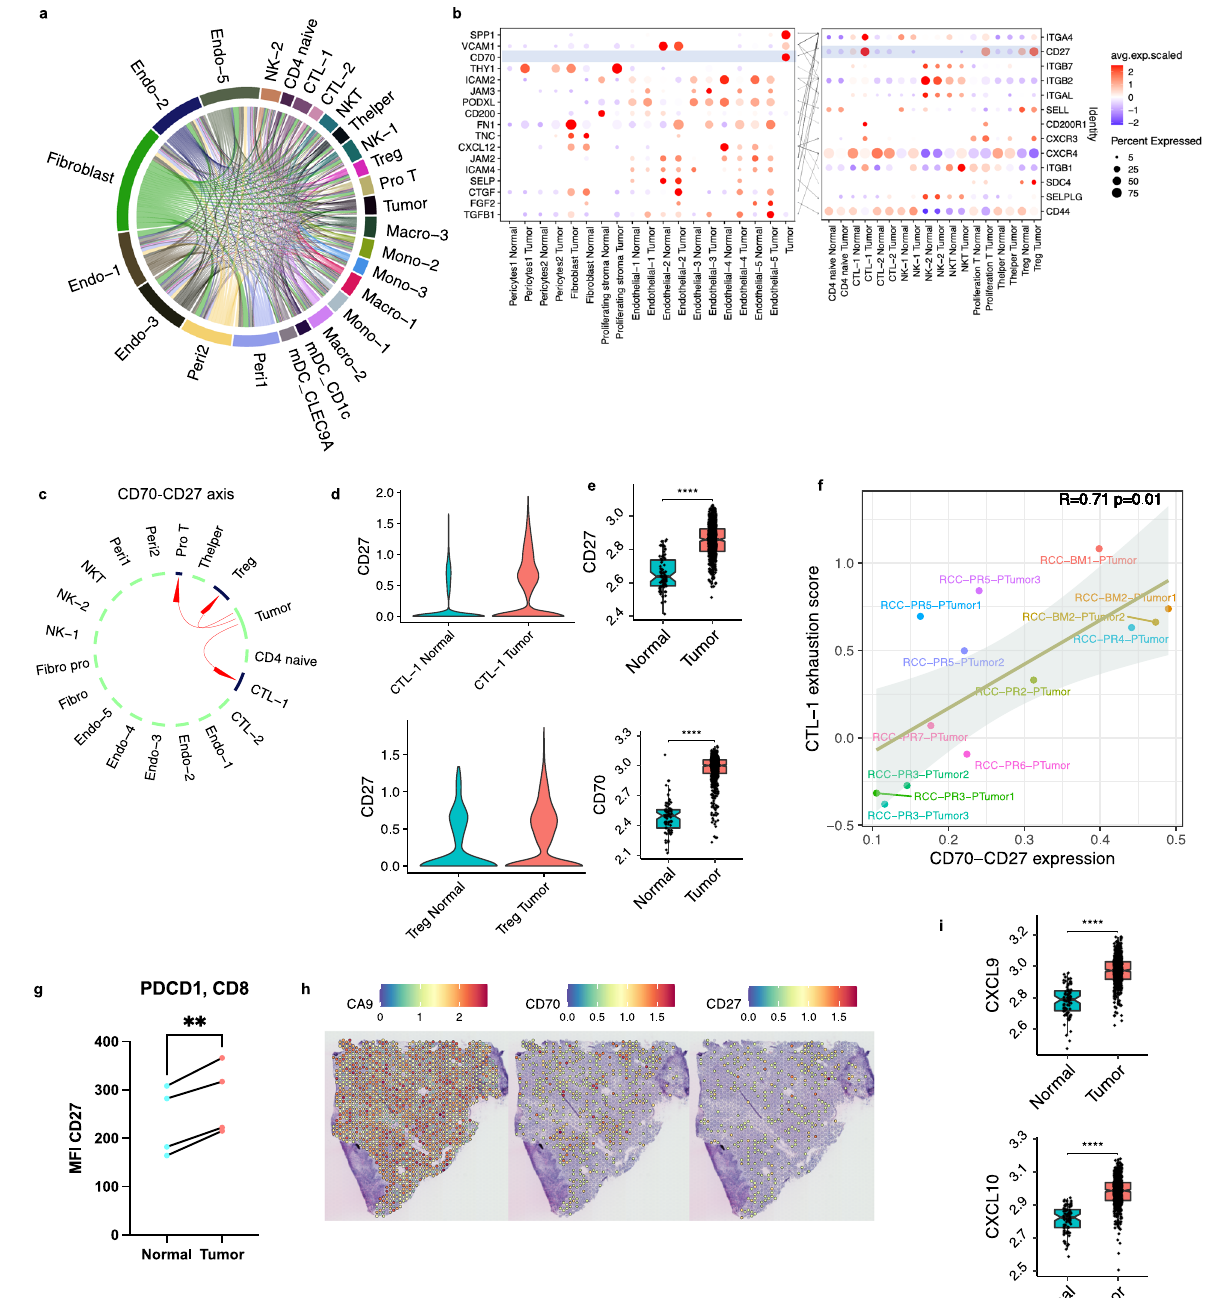
Fig. 5 | Cell – cell interaction analysis reveals potential therapeutic targets in ccRCC.a Overviewofpotentialligand-receptorinteractionsofcellsubpopulations. b Bubble heatmap showing expression of ligand (tumor cells and stromal cell subsets)andreceptor(immunecellsubsets)pairsindifferentstromalandimmune subsets. Dot size indicates expression ratio, color represents average gene expression.Signi fi canceofligand-receptorpairisdetermined by permutationtest, gene differential expression analysis and speci fi c cellular expression (Methods). c The predicted interactions between CD70 and CD27 . d Violin plot showing CD27 expressioninCTL-1 and Tregs. e CD27 and CD70 expression in TCGAKIRCdataare shown as boxplot. Statistics are accessed with a two-side Wilcoxon rank-sum test ( CD27 **** p <2e-16; CD70 ****p <2e-16. Sample size: Tumor n =533, Normal n =53). Boxplots include center line, median; box limits, upper and lower quartiles; and whiskers are highest and lowest values no greater than 1.5× interquartile range.